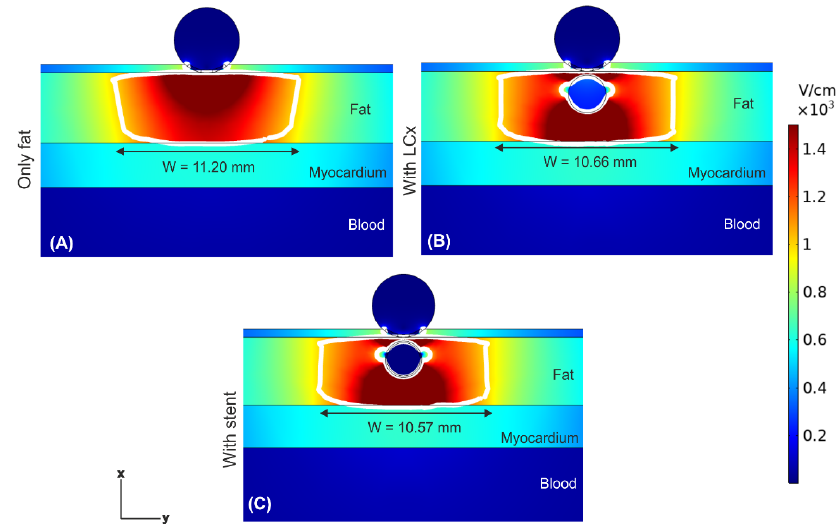
Figure 5. Electric field distributions after a train of ten PEF pulses (100 μs between them) for a distance of 0.25 mm between ablation electrode and artery/stent. Different scenarios were compared: ( A ) epicardial fat layer without artery, ( B ) artery without stent, and ( C ) artery with stent. The white contour corresponds to the 1000 V/cm electric field isoline and defines the PEF-zone.